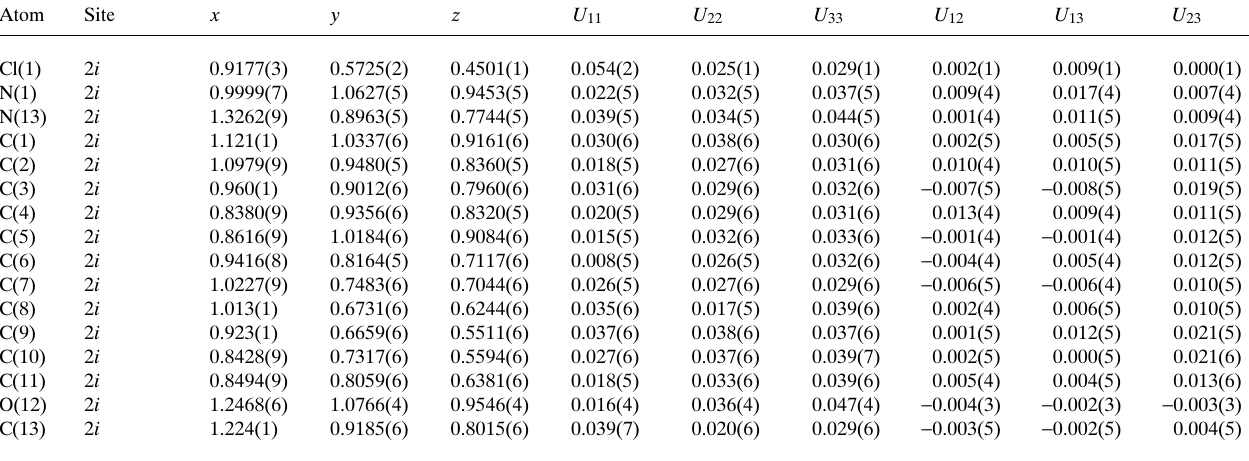
Table 3. Atomic coordinates and displacement parameters (in Å 2 )